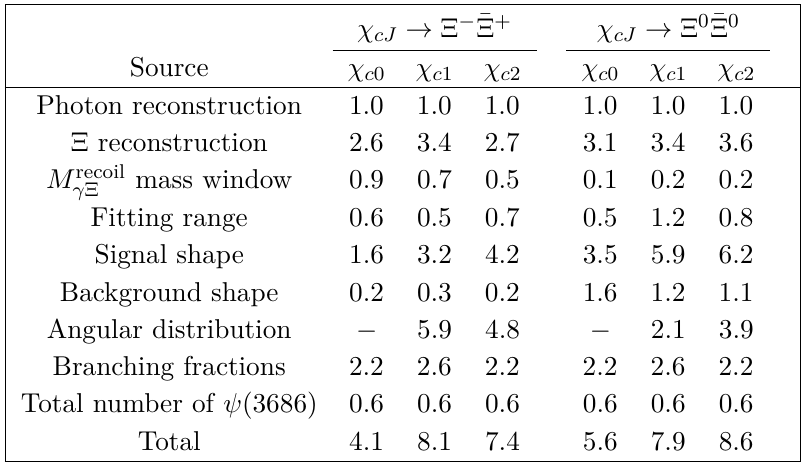
Table 3 . Systematic uncertainties on the branching fraction measurements (in %).